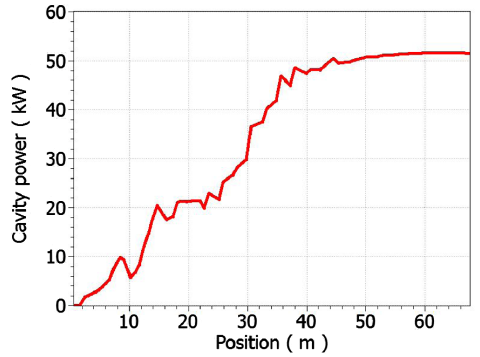
FIG. 41. Cavity power along the MEHIPA linac.